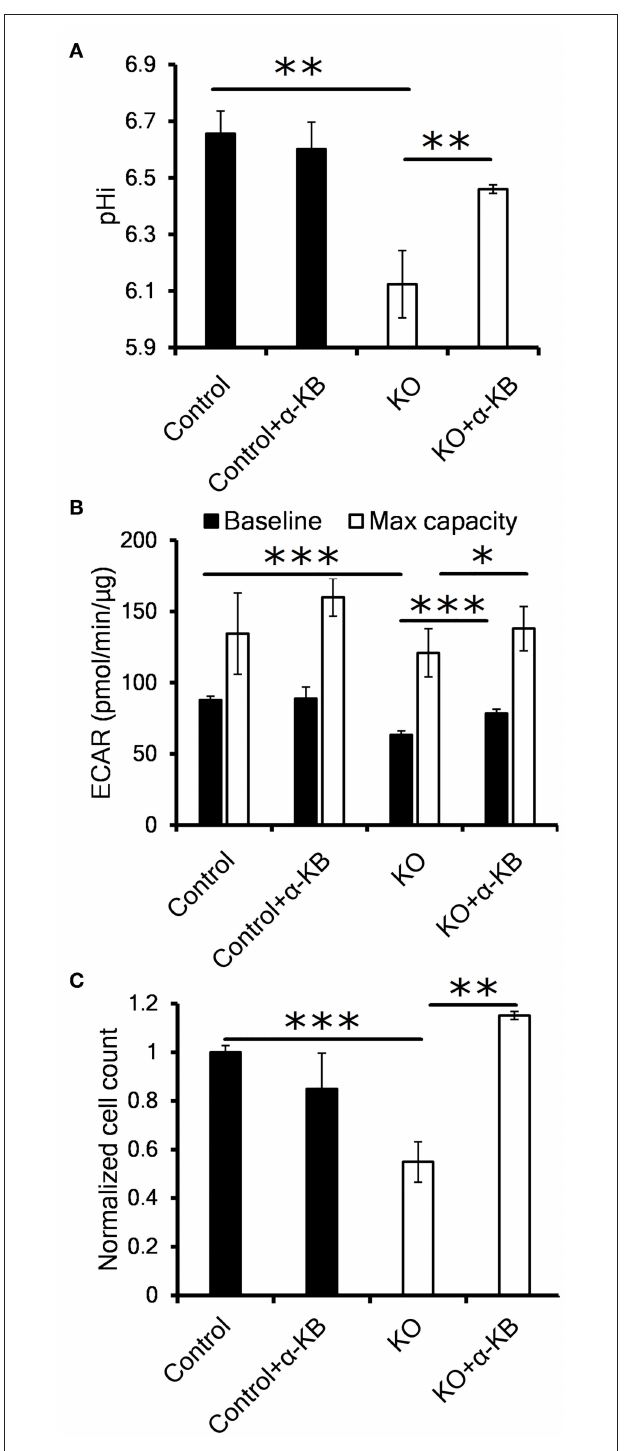
FIGURE 3 | Alternative LDH substrate alpha-ketobutyrate restores pHi, proliferation and LDH activity in CA IX deficient cells. (A) Intracellular pH (pHi) of HT-1080 KO cells incubated for 48h in 1% O 2 with 1mM alpha-ketobutyrate ( α -KB). (B) Seahorse analysis of baseline ECAR (black) and the maximal glycolytic capacity (white) of HT-1080 KO cells. (C) Normalized cell number of HT-1080 KO cells after 72h in 1% O 2 in the presence or absence of α -KB. Error bars are ± SEM. P -values were calculated against control by t -test. * P < 0.05; ** P < 0.01 *** P <